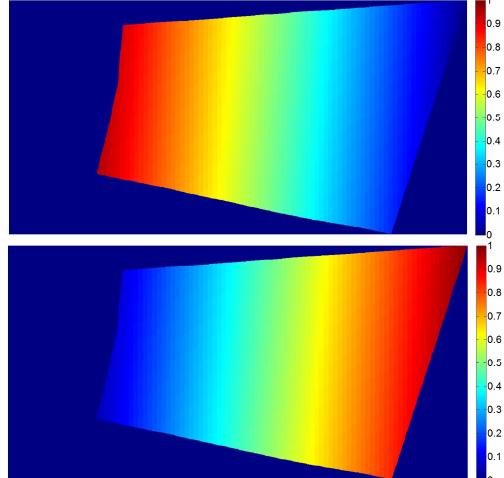
Figure 2. Weight map for local warping (top) and global similarity transform